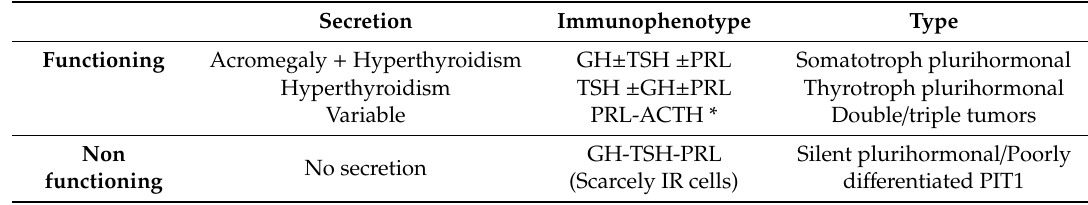
Table 2. Plurihormonal tumors of PIT1